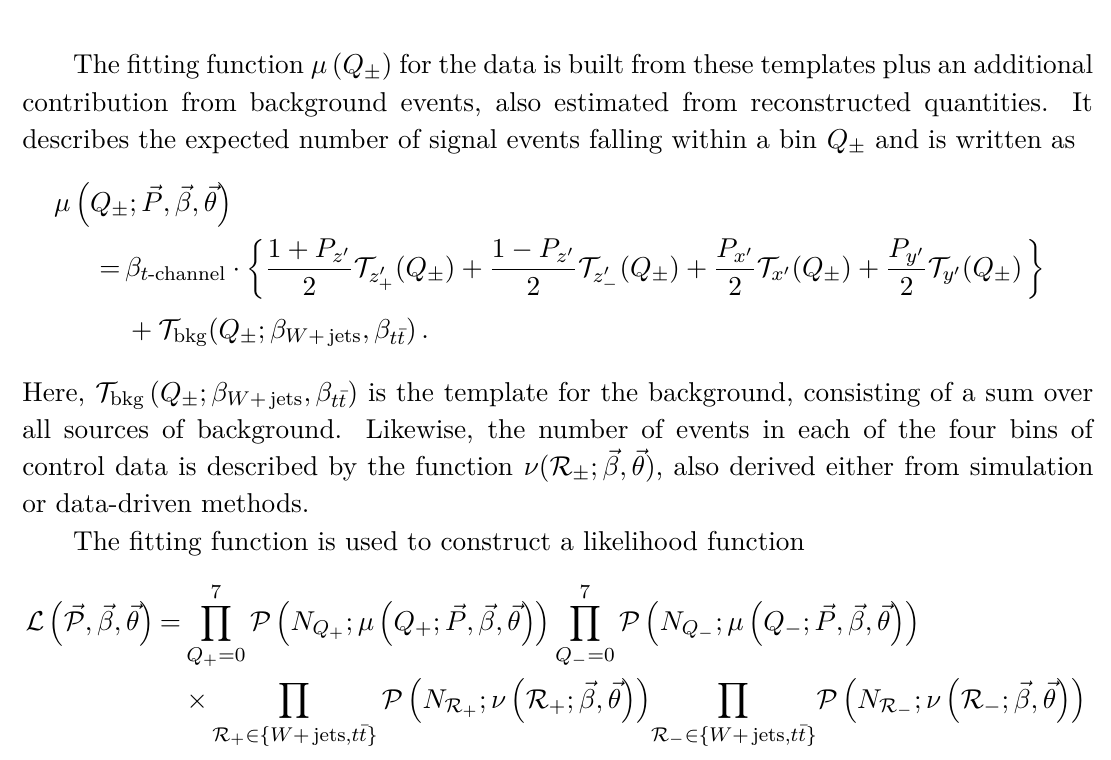
, cos θ , cos θ ‘x 0 ‘y 0 ‘z 0